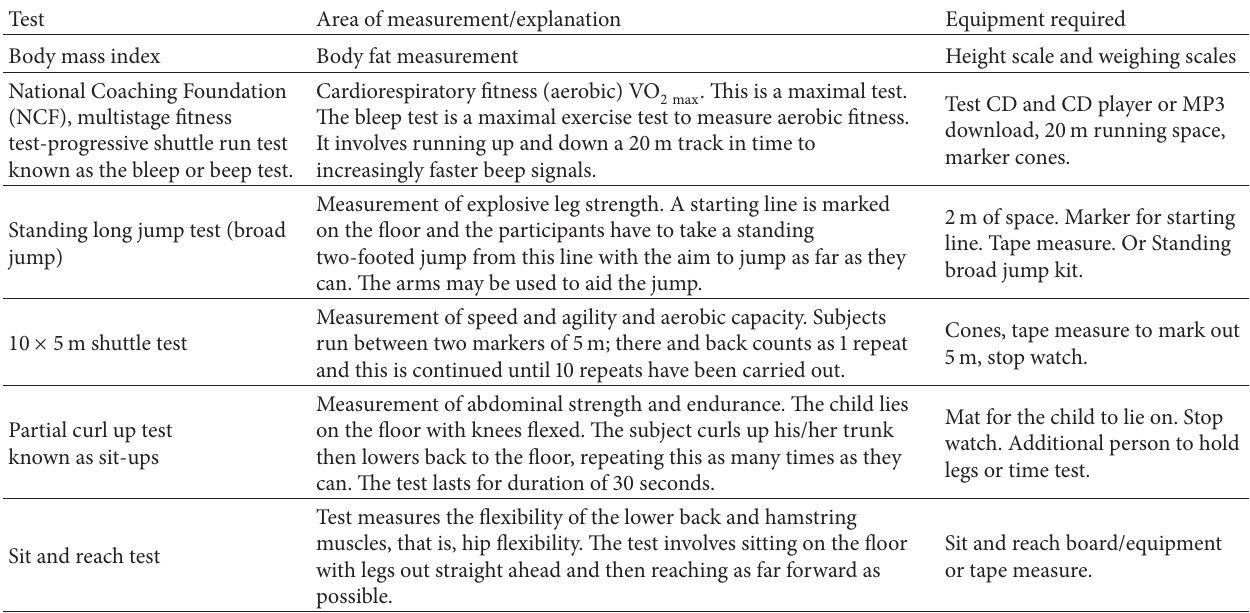
Table 1: Fitness tests used in the study.